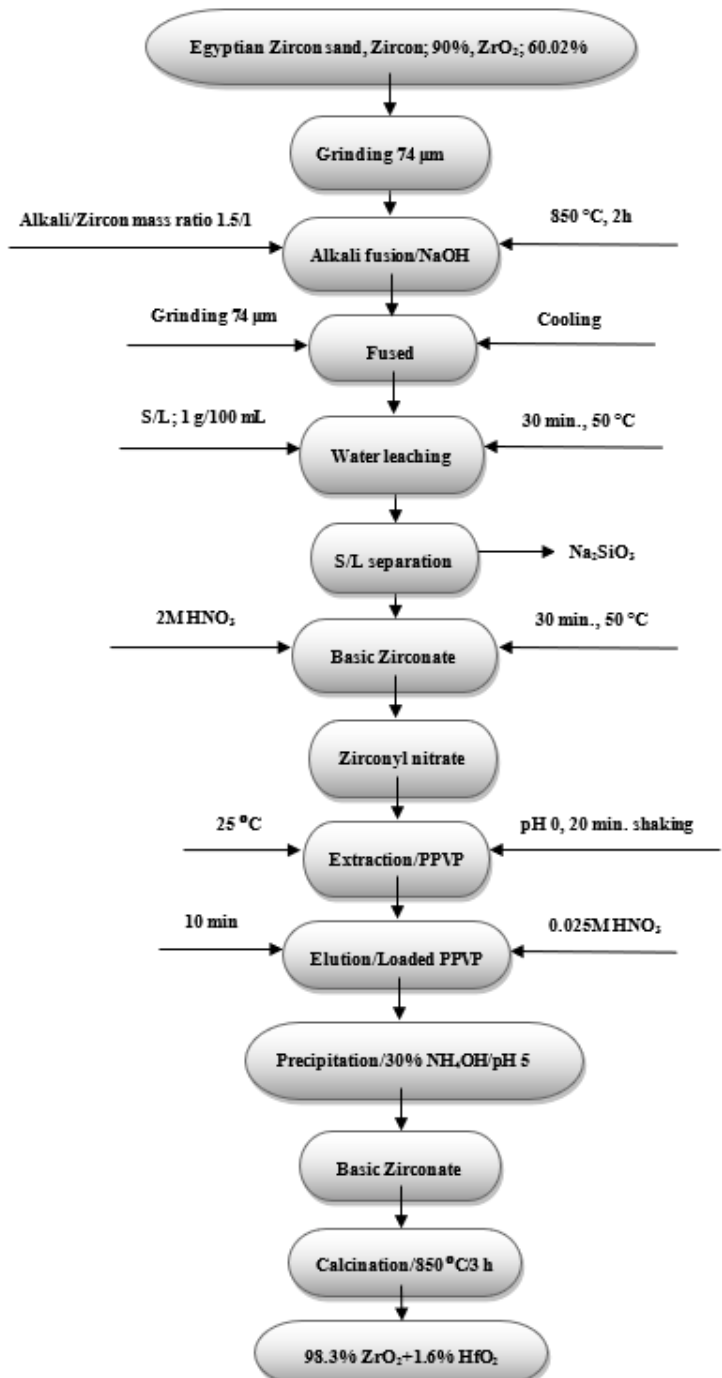
Figure 17. A flow chart with zirconium mass balance for the preparation of highly pure ZrO 2 from Egyptian Zircon sand using PPVP composite.